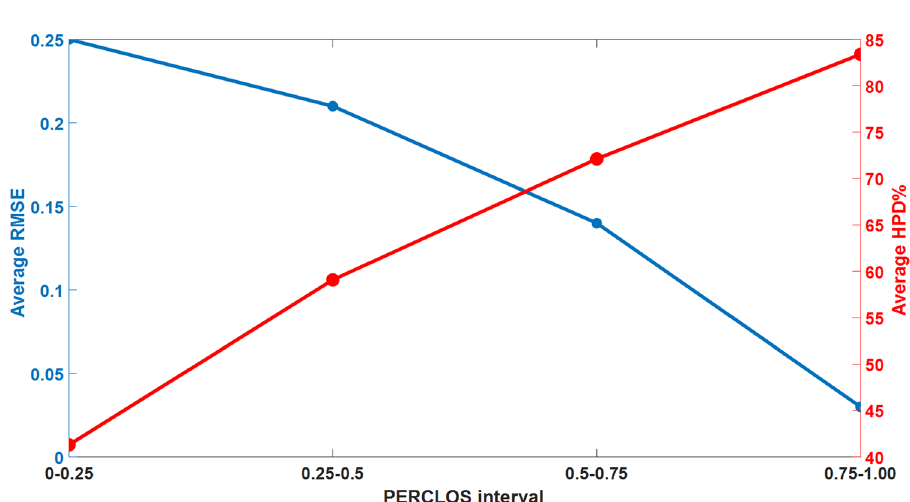
Figure 11. The average RMSE and HPD percentage in different PERCLOS intervals. This Figure shows that the proposed method is performing better in higher values of PERCLOS that are more important to detect the moderate and extreme levels of driver drowsiness. Tests with the IDs of 6, 9, and 15 are used as test